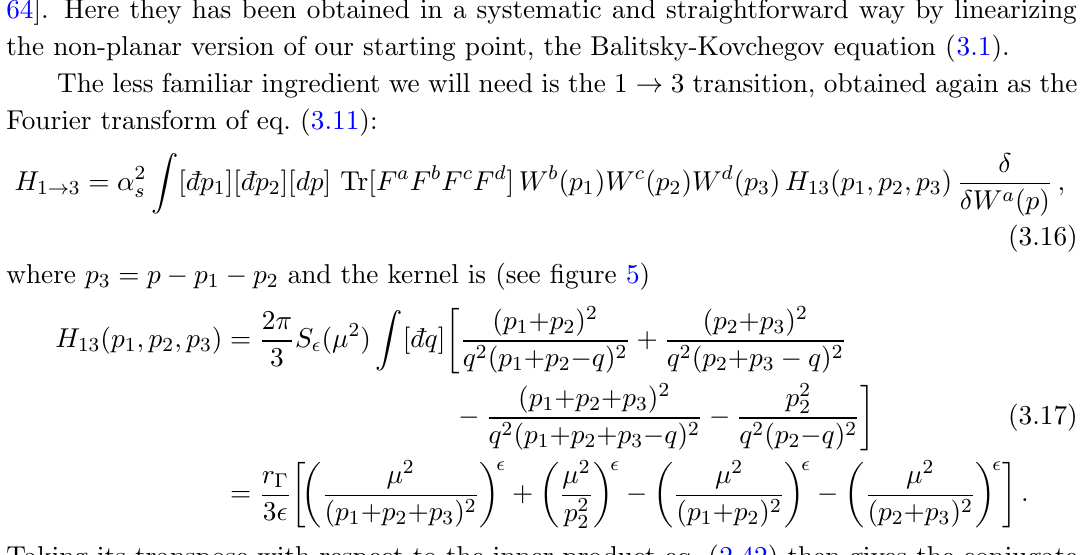
3 and 3 1 evolution, i.e. ! ! 3 and 3 1 ! !